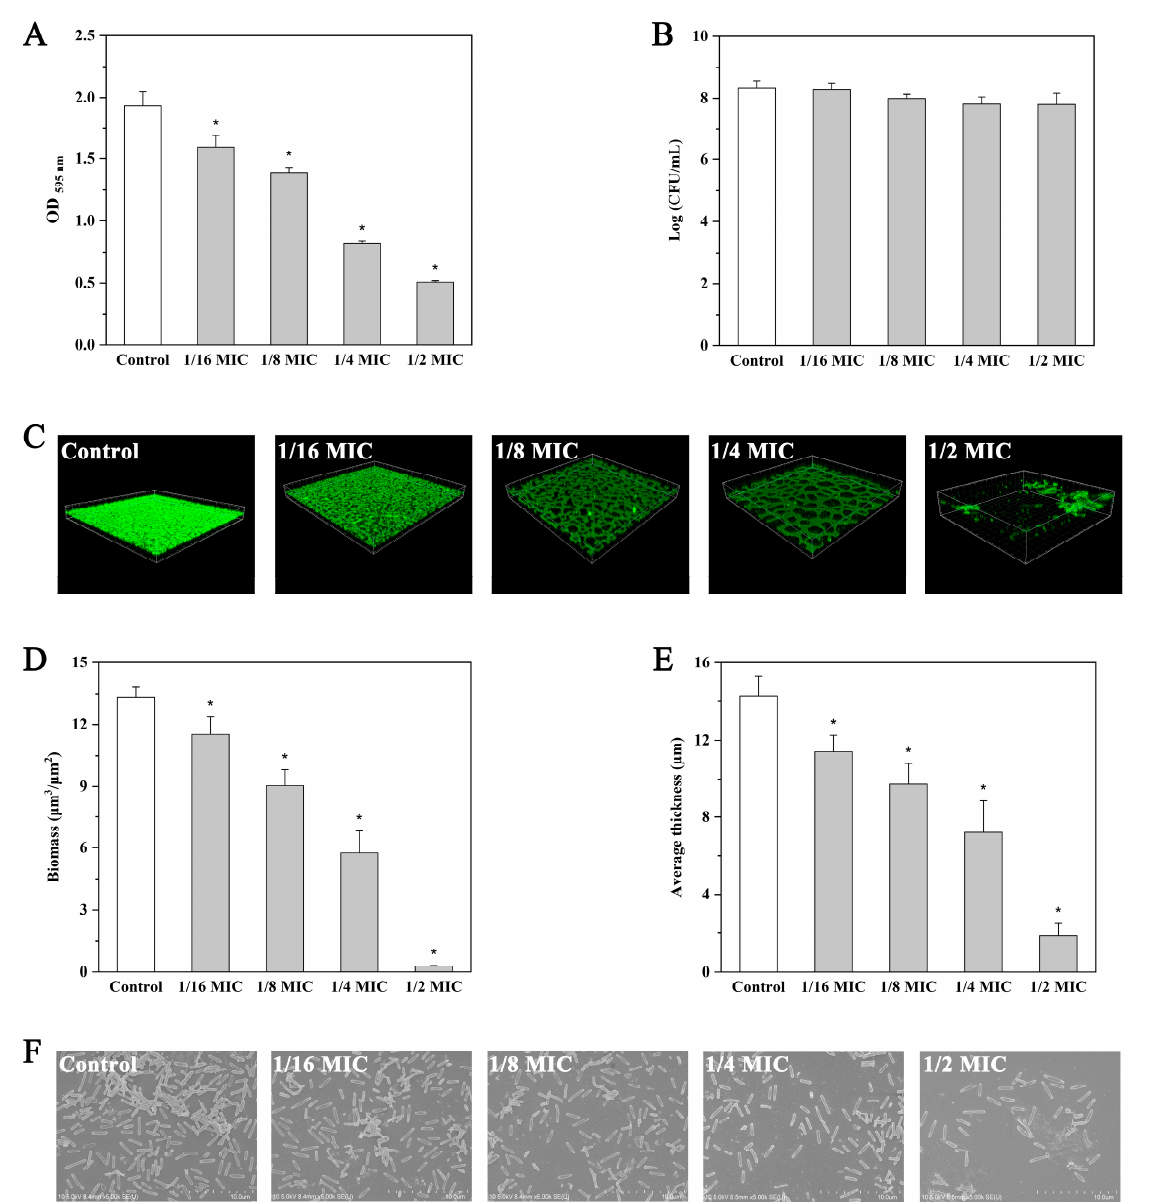
Figure 3. Effect of andrographolide on biofilm formation. ( A ) Biofilm assay by microtiter plater with crystal violet staining. ( B ) Surviving planktonic cells in the bacterial culture. ( C ) CLSM images. ( D ) The biofilm biomass of CLSM analysis. ( E ) Mean thickness of biofilm by CLSM analysis. ( F ) SEM images. Error bars represent the standard deviation of triplicate experiments ( n = 3). The asterisk indicates a value statistically different from that of the control, with p <